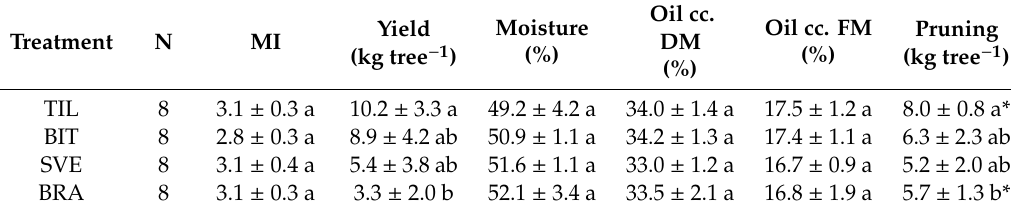
Table 6. Maturity index, yield, humidity, and oil accumulation for the di ff erent treatments and years.